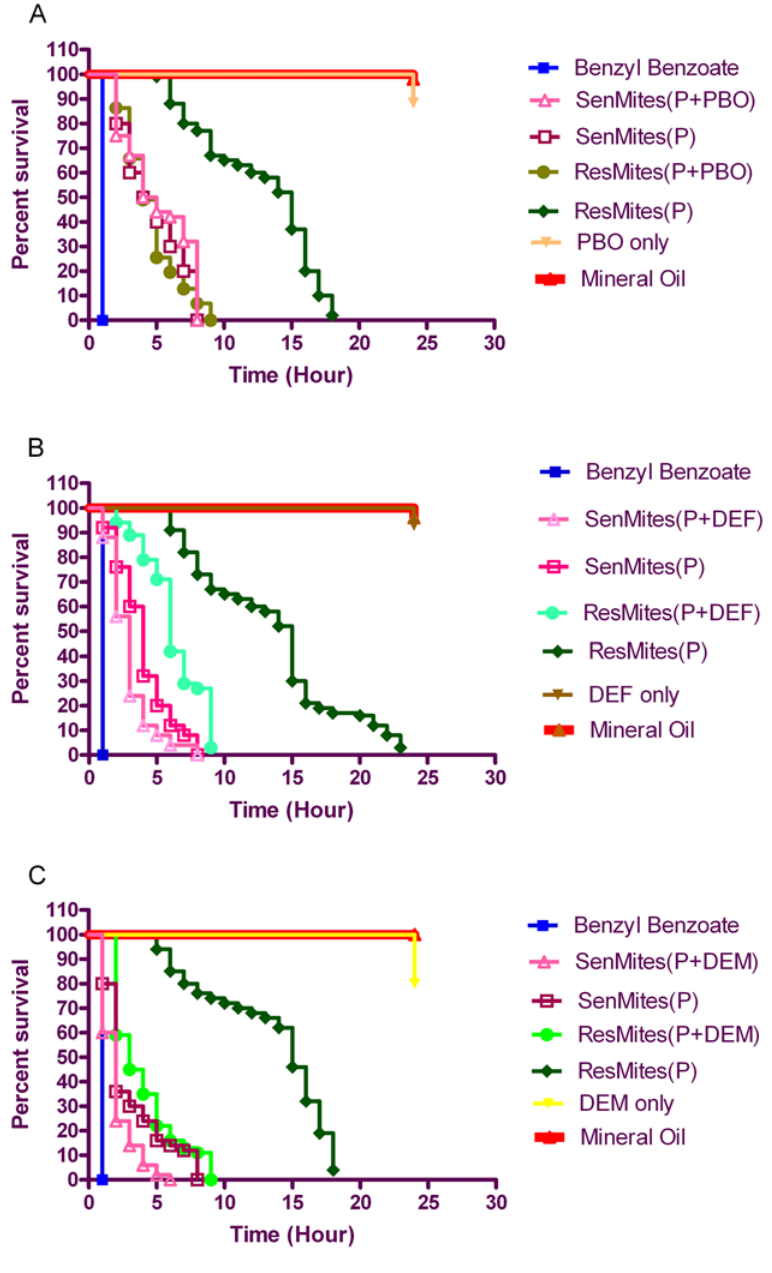
Figure 1. Survival of Permethrin (P) Resistant (Res) and Sensitive (Sen) Mites with or without Synergists. A. Survival of scabies mites using PBO (Piperonyl Butoxide) as synergist to permethrin. B. Survival of scabies mites using DEF (S,S,S-tributylphosphorotrithioate) as synergist to permethrin. C. Survival of scabies mites using DEM (Diethyl Maleate) as synergist to permethrin. Benzyl Benzoate was used as positive control and Mineral Oil was used as negative control. Synergist (PBO, DEF and DEM) only controls were also included in the bioassays.